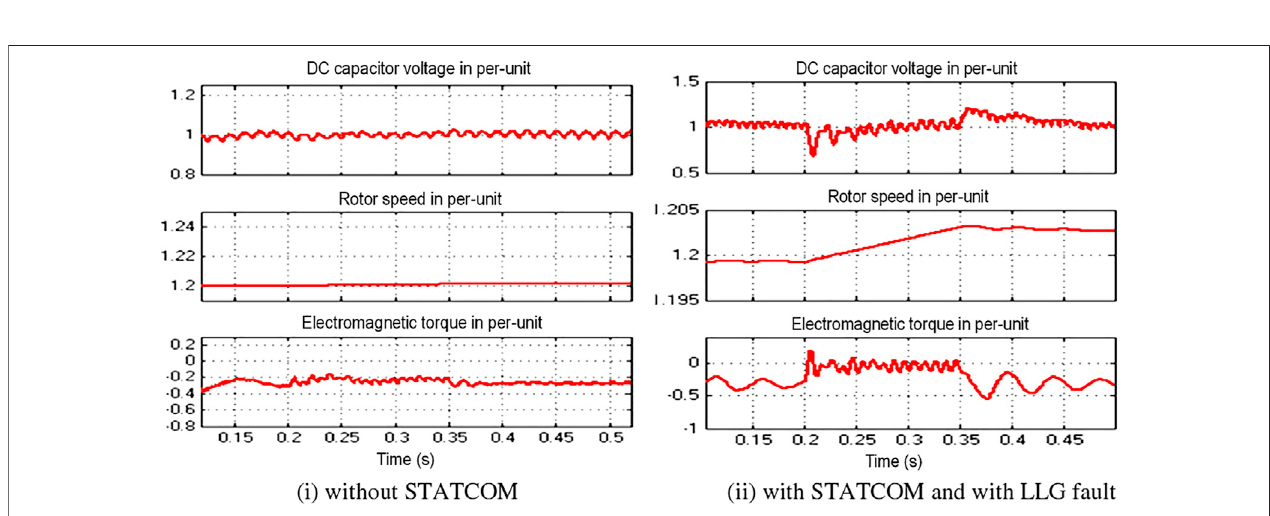
FIGURE 8 | Back-to-back capacitor voltage, rotor speed, and electromagnetic torque of the DFIG. (i) Without STATCOM. (ii) With STATCOM and with LLG fault.